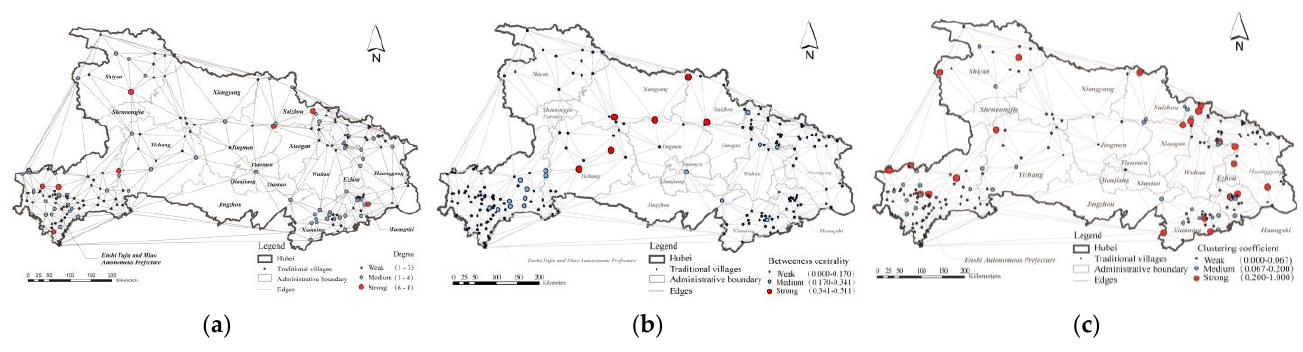
Figure 5. ( a ) Result of degree; ( b ) Result of betweenness centrality; ( c ) Result of clustering coeffi- cient.